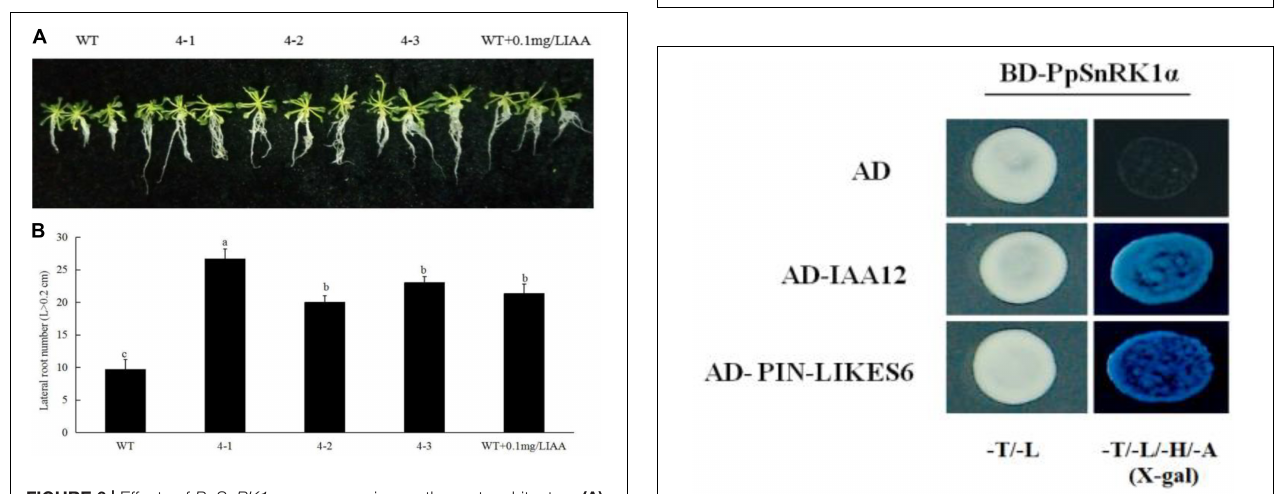
FIGURE 6 | Effects of PpSnRK1 α overexpression on the root architecture (A) and lateral root number (B) in Arabidopsis thaliana. Error bars represent the averages of three biological replicates ± SD. Different letters represent differences between different processes. Significance was defined at P < 0.05.